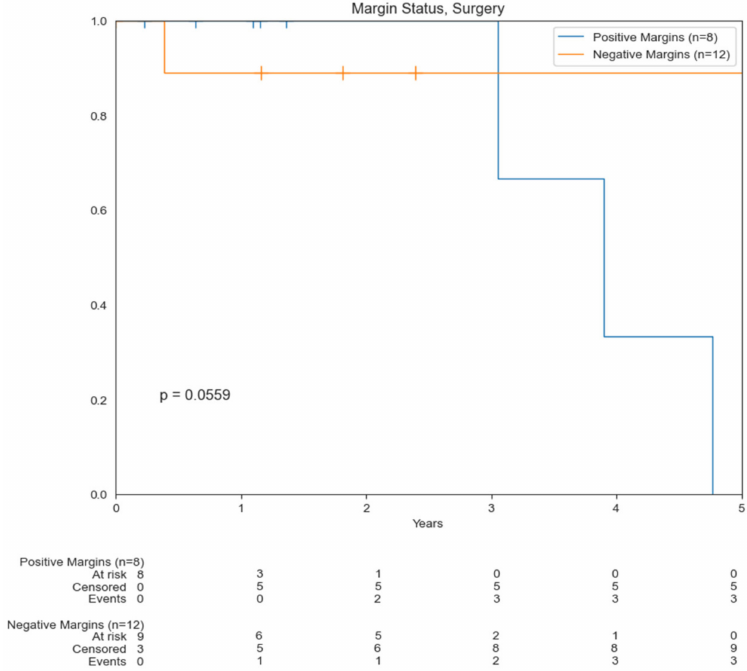
Figure 4. Kaplan–Meier curves comparing OS based on margin